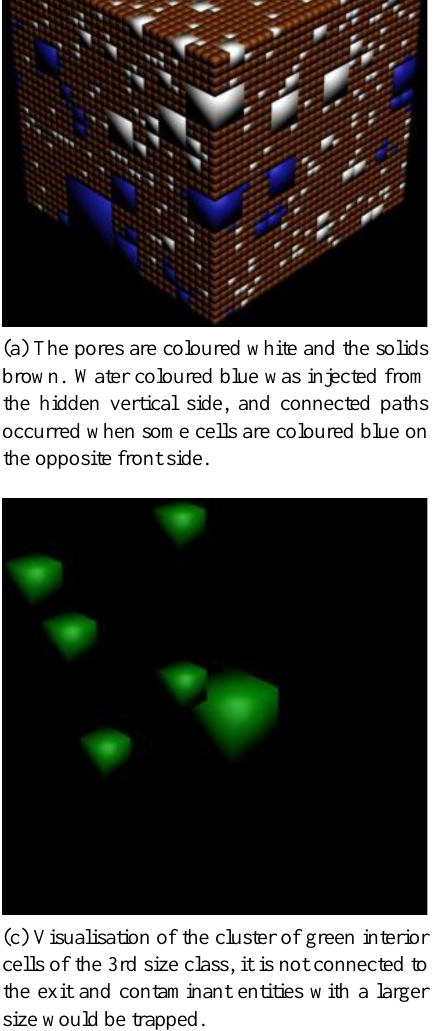
Fig. 2. A 3-D illustration for a random realisation of a fractal cube defined by n = 2, q = 0 . 1 and i = 10 iterations. Only the first 5 levels and associated 5 pore sizes are drawn. No pores of the 1st level occurred due to low q